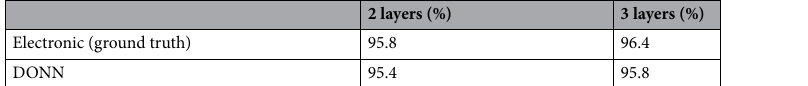
Table 1. MNIST classification accuracy of DONN (no crosstalk correction applied) versus all-electronic hardware with custom fully-connected neural network